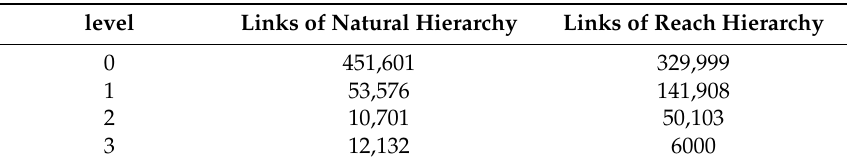
Table 4. The Information of the Device used in our Experiment.